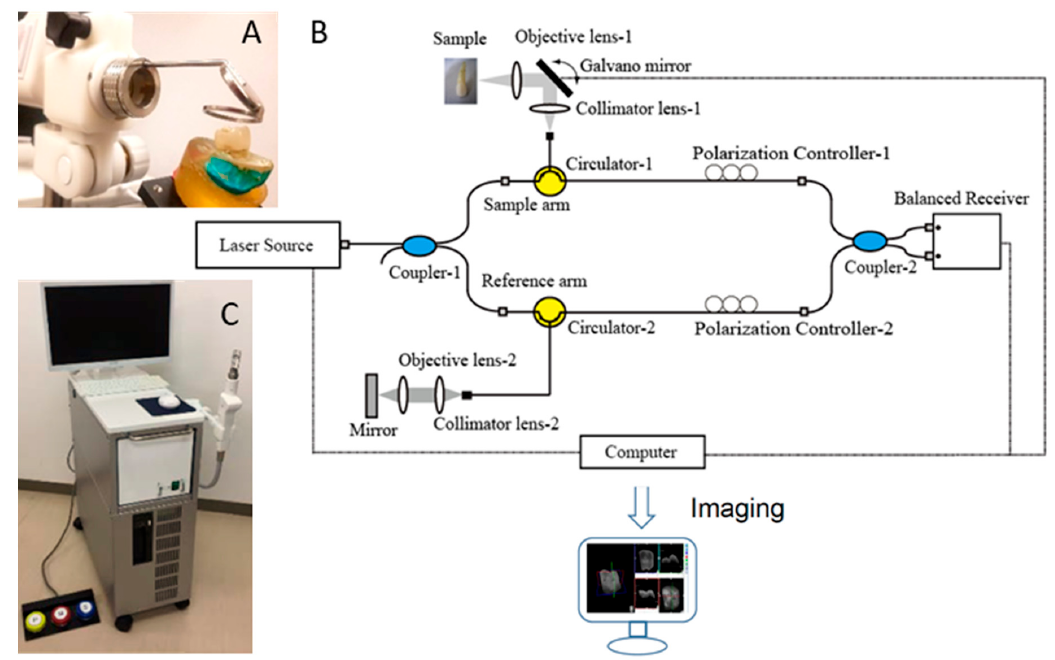
Figure 1. Prototype Yoshida Dental optical coherence tomography (OCT) system. ( A ) Specimen positioning to image the occlusal surface with the intraoral mirror tip for posterior teeth imaging attached to the handheld probe; ( B ) schematic diagram OCT system. An interference pattern is produced by splitting the beam of the Micro Electro Mechanical System (MEMS)-based laser source into two arms (i.e., reference arm and sample arm). The backscattered light from the sample is redirected back and recombined with the light from the reference arm in the coupler. The interference signal is transformed into raw A-scan data. Series of A-scans produce raw B-scan (2D) and the composition of 2D leads to the acquisition of 3D images; ( C ) overview of the OCT system with foot pedal for clinical imaging.